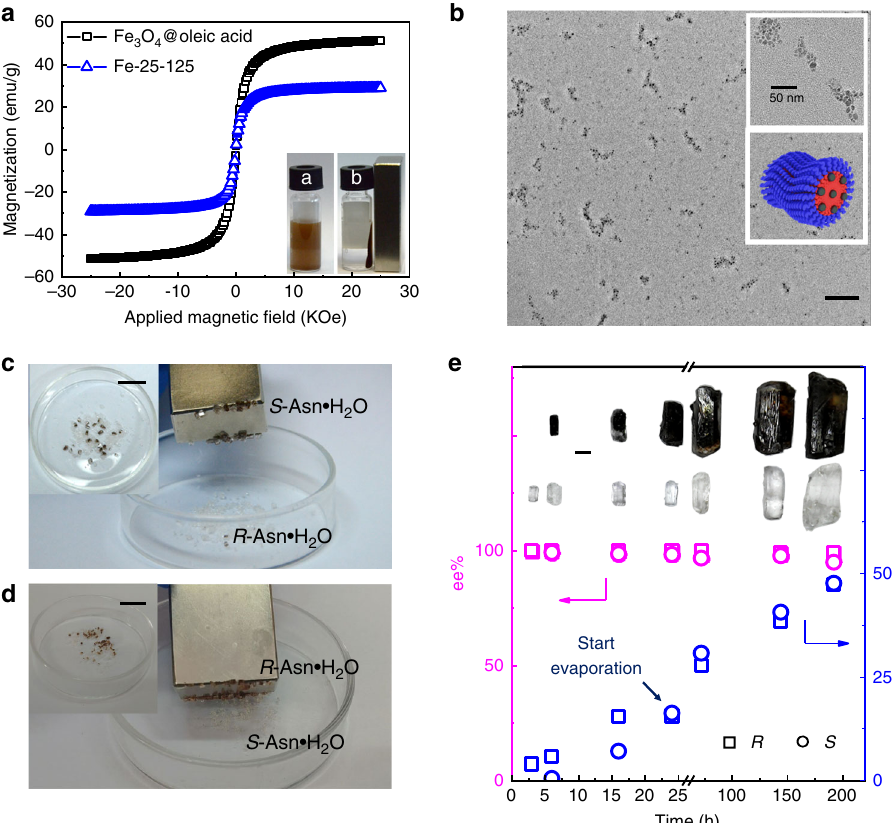
Fig. 2 Properties of the nano-splitters and their application in selective crystallization. a The magnetic hysteresis loops of Fe 3 O 4 MNPs and S -Fe-25 – 125 (inserted pictures: the aqueous dispersion of magnetic nano-splitters (bottle a) and the separability of the co-assemblies by placing an external magnetic fi eld (bottle b). The time from state a to state b is within 20 s. b The TEM images of S -Fe-25 – 125 (inserted pictures: magni fi ed images (top) and 3D model of the co-assemblies (bottom)). c The images of R and S -Asn (cid:129) H 2 O crystals by using S -Fe-25 – 125 as additive. d the images of S and R -Asn (cid:129) H 2 O crystals by using R -Fe-25 – 127 as the additive. e The variations of chemical yield and ee% of R/S -Asn (cid:129) H 2 O crystals over time by using 0.5 wt% of S -Fe-25 – 125 as the additives for strong magnetic responsiveness of S -crystals, the solvent was slowly evaporated after 24 h (inserted picture: magni fi ed images of the two kinds of crystals growing over time). Scale bars: 100 nm ( a ); 2 cm ( c ); 2 cm ( d ); 1 mm ( e